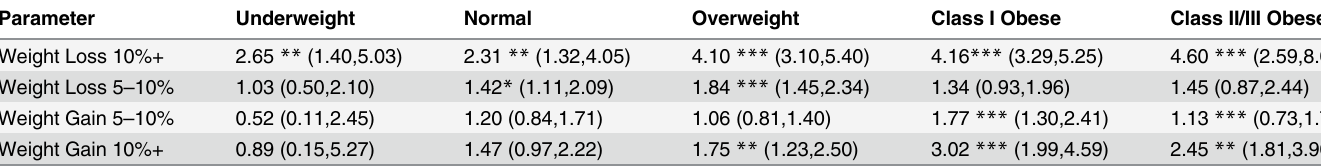
Table 5. Marginal Structural Models by Baseline Weight